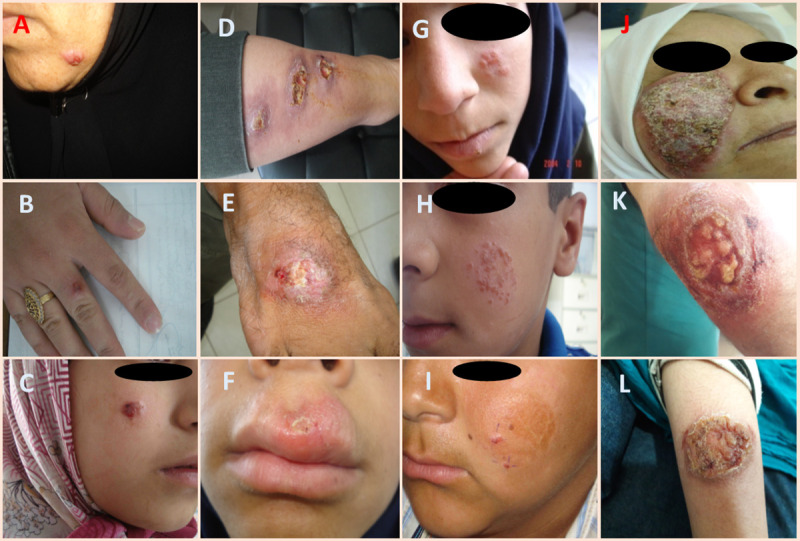
Representative images of various clinical forms of anthroponotic cutaneous leishmaniasis from Kerman district.A) a responsive form with erythematous nodular indurated plaque on the face, B) a responsive form with a crusted nodule on the hand, C) a responsive form with a crusted plaque on the face, D) a treatment failure form consisting of three ulcerated indurated erythematous plaques on the leg, E) a treatment failure form with an indurated crusted plaque on the leg, F) a treatment failure form with a crusted large plaque on the lip, G) a relapse (lupoid) form with erythematous apple jelly-like indurated papules around and within the scar on the cheek, H) a relapse (lupoid) form with apple jelly nodules around and within scar of the left cheek [21], I) a relapse (lupoid) form with popular lesion around the scar on the left cheek, J) a chronic form with a large erythematous crusted scaling indurated plaque on the right cheek, K) a chronic form with indurated erythematous exudation ulcer of the forearm, L) a chronic form with an ulcerated plaque of elbow area.